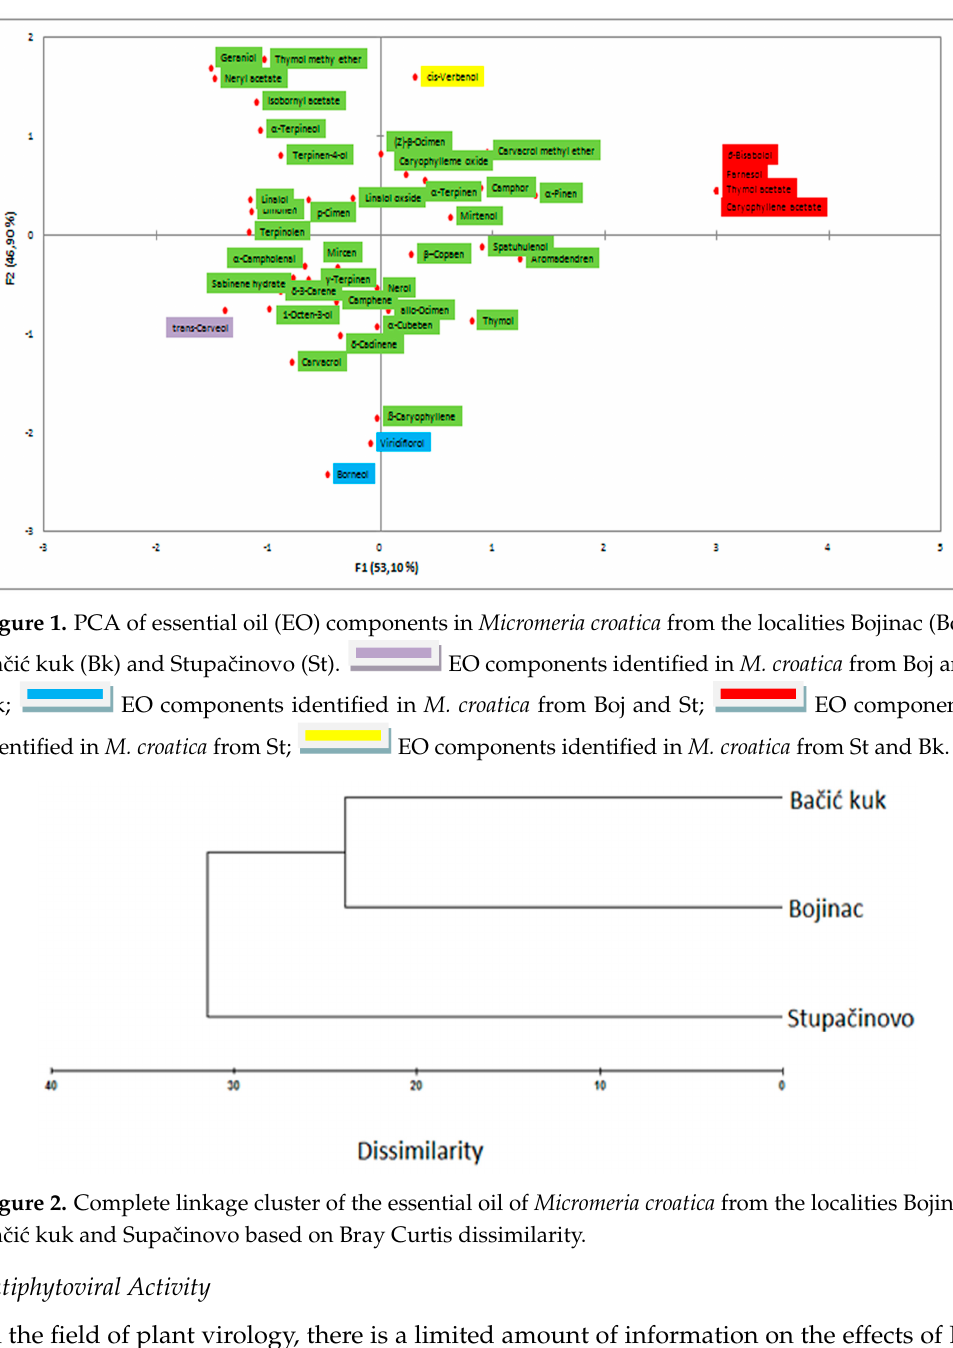
Figure 2. Complete linkage cluster of the essential oil of Micromeria croatica from the localities Bojinac, Ba č i ć kuk and Supa č inovo based on Bray Curtis dissimilarity.